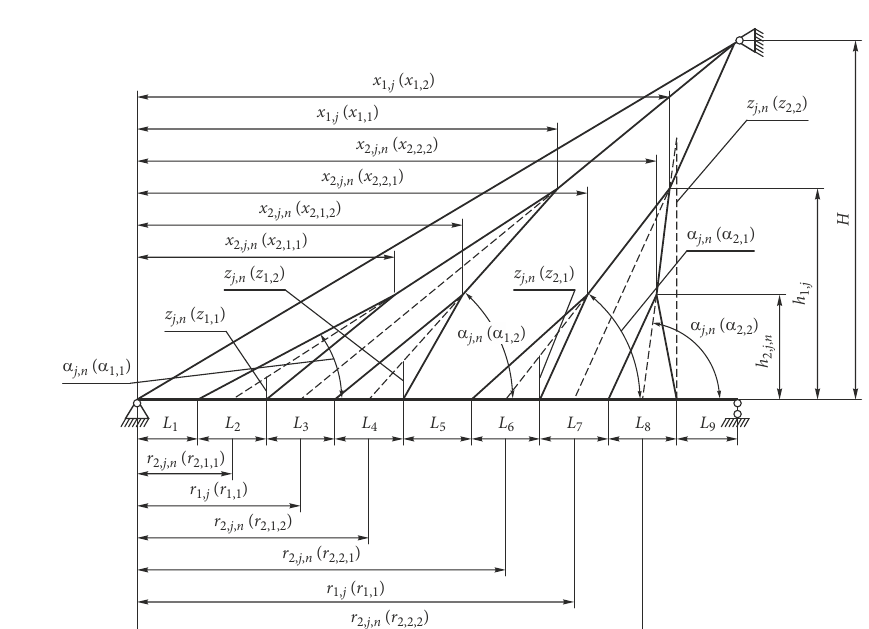
Figure 3. Cable connection coordinate calculation scheme